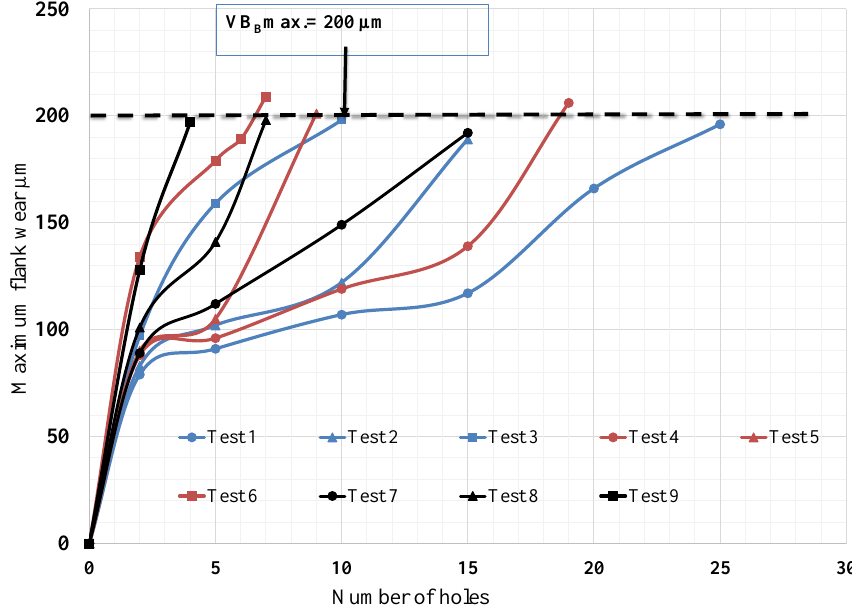
Figure 7. Flank wear against the number of holes for the central insert.